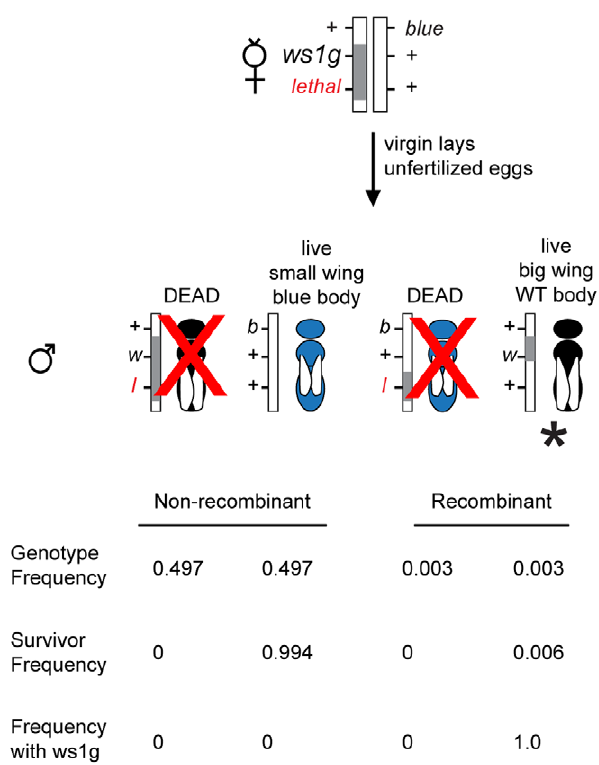
Figure 2. Positional cloning in Nasonia using linked lethals. The diagram illustrates a screen for fine-scale recombinants (marked with *) between ws1 g and a lethal located 0.6cM away. Because of the lethal ( l ), the only live haploid males with ws1 g (large wings, w ) are recombinant. The blue ( b ) marker is used as a second phenotypic marker and as a way to identify recombinants on the other side of ws1. Gray bar: introgression ( N. giraulti ) sequence. White bar: N. vitripennis sequence. Proportions shown are based on estimates of recombination rates between the markers (Figure 3) and assuming no double recombinants. clone ws1 despite a 10-fold lower recombination rate in this region, 0.10–0.14 centimorgan/megabase (cM/Mb) relative to the